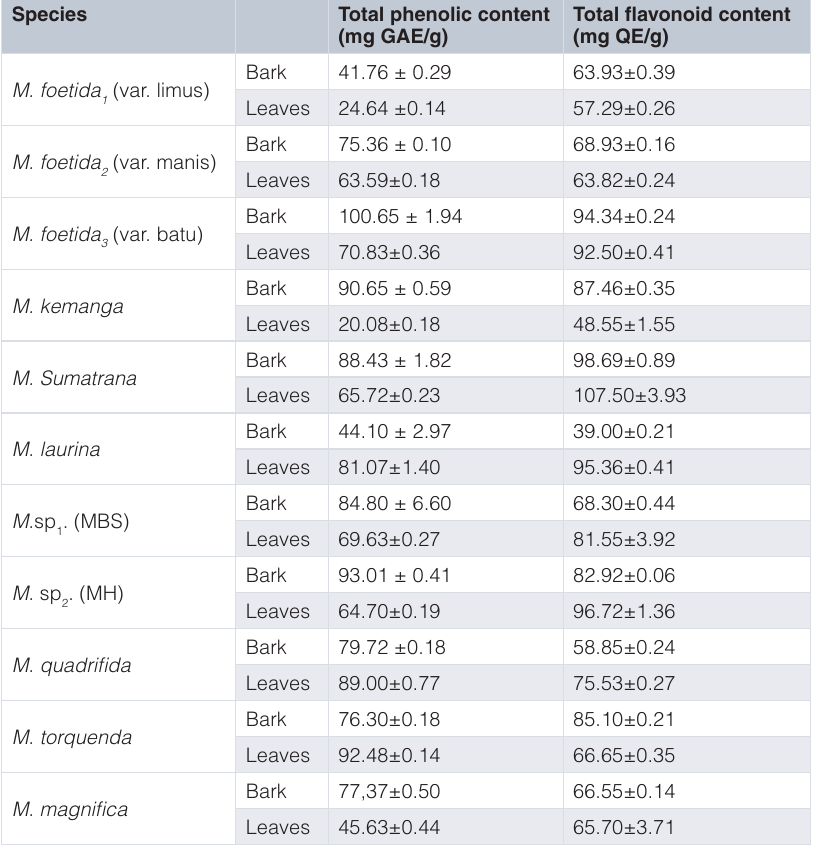
Table 2. Total phenolic and flavonoid content of wild mango species from Sumatran,